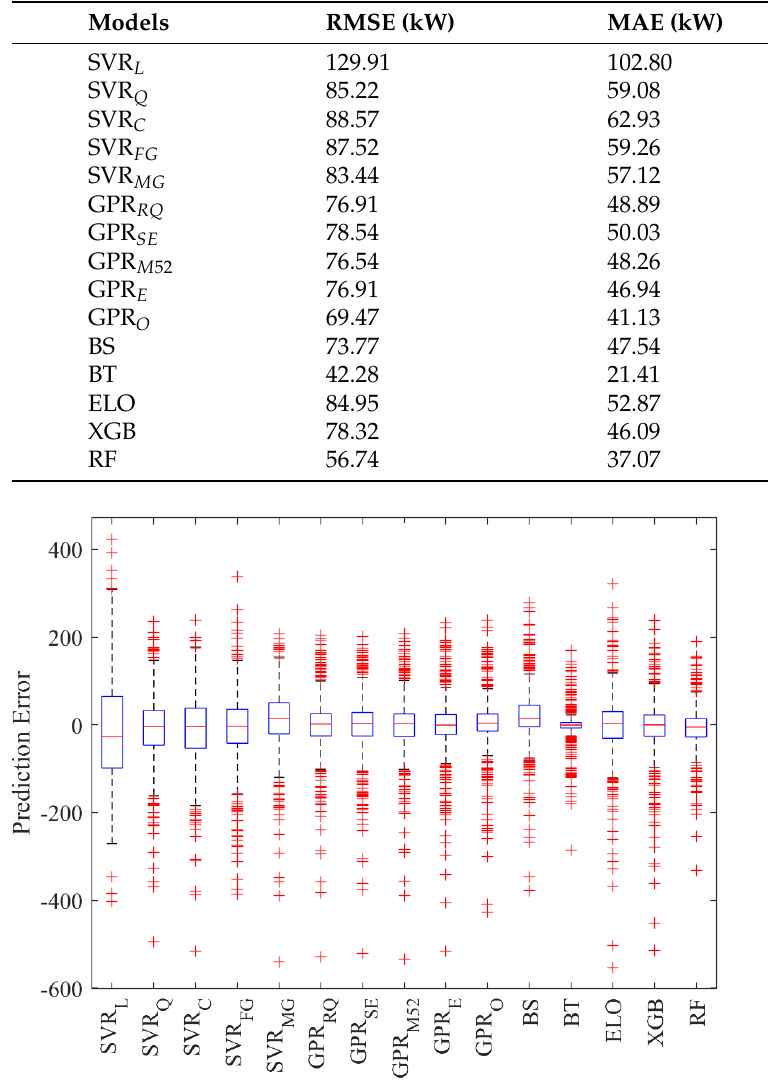
Figure 14. Boxplots of prediction errors from the testing data.